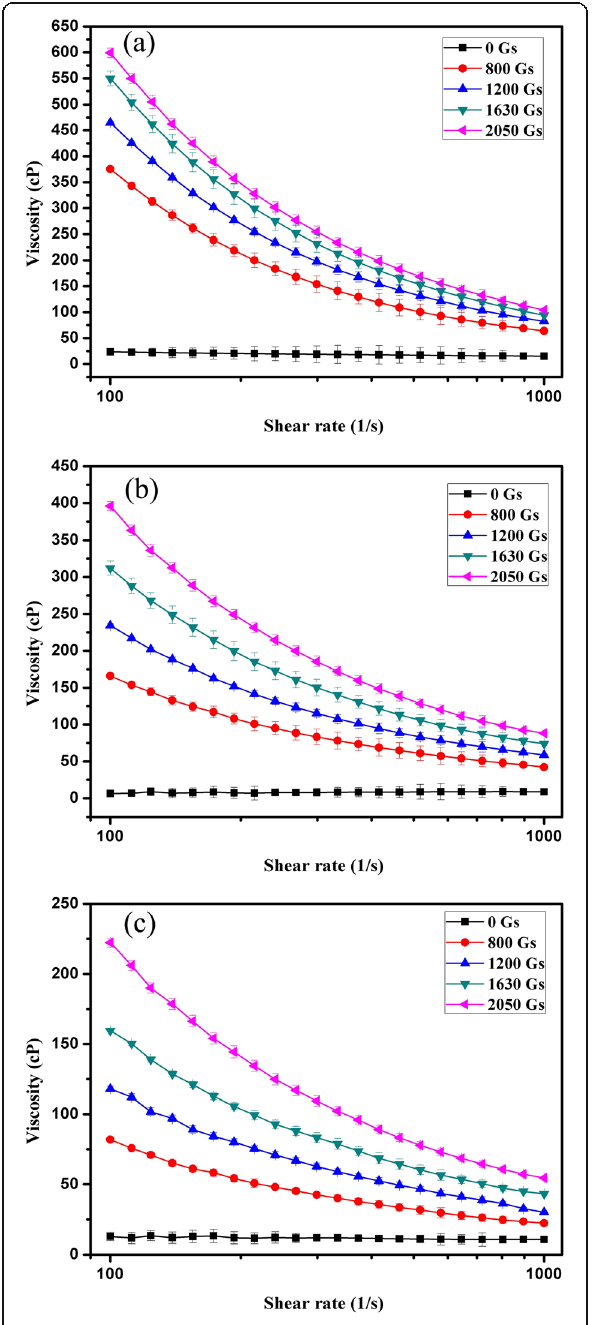
Fig. 6 The viscosity as a function of magnetic field for Fe-B FF ( a ), Fe-Ni-B FF ( b ), and Co-B FF( c